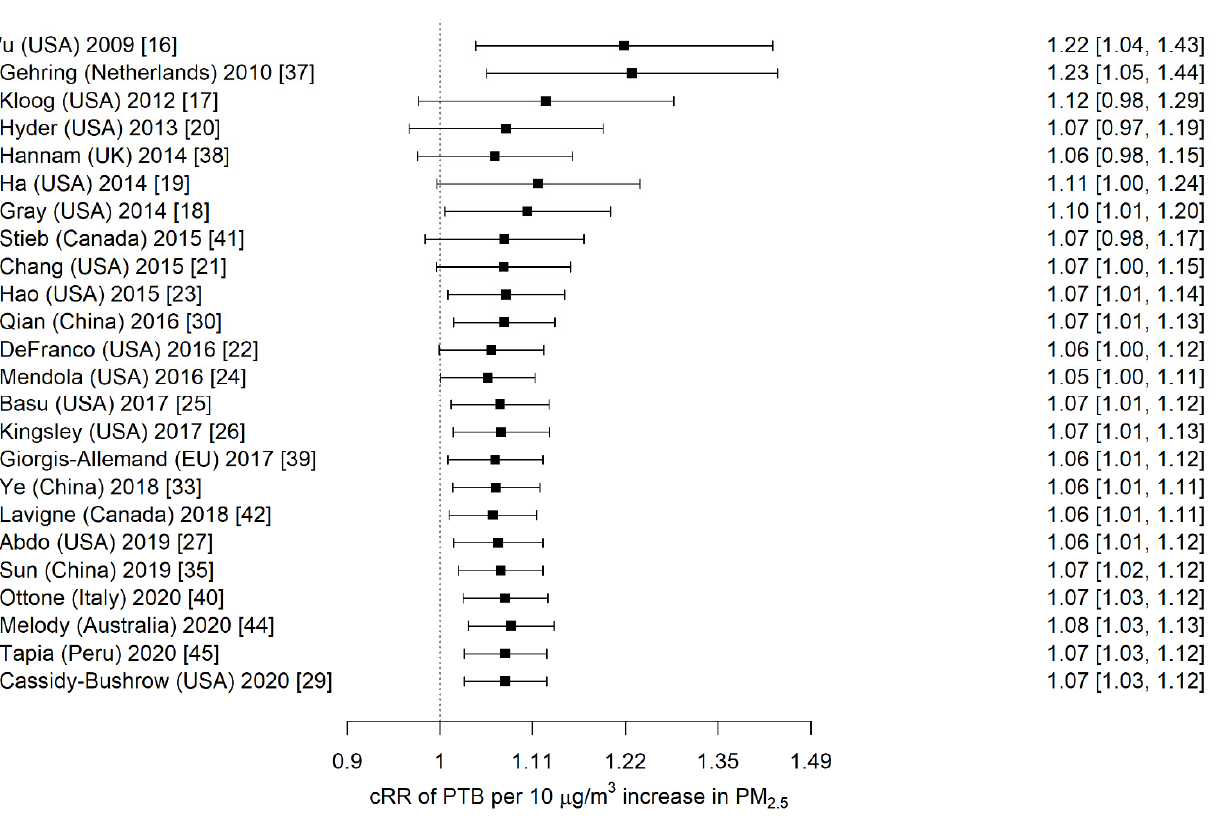
Figure 1. Converging cumulative relative risks (cRR) with each successive publication on the associa- tion between preterm birth (PTB) and whole-pregnancy exposure to fine particulate matter (PM 2.5 ). The “+” symbol indicates sequential addition of the study results to those previously published. Table 1. Cumulative relative risks (cRR) of preterm birth (PTB) per 10 µ g/m 3 increase in fine particulate matter (PM 2.5 ) and accumulating heterogeneity (I 2 ) over time, with the relative risk needed for a new study to render the pooled estimate null (stability threshold,